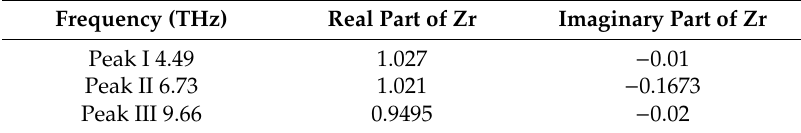
Table 3. Calculations of relative impedance of the proposed structure at peak frequencies.